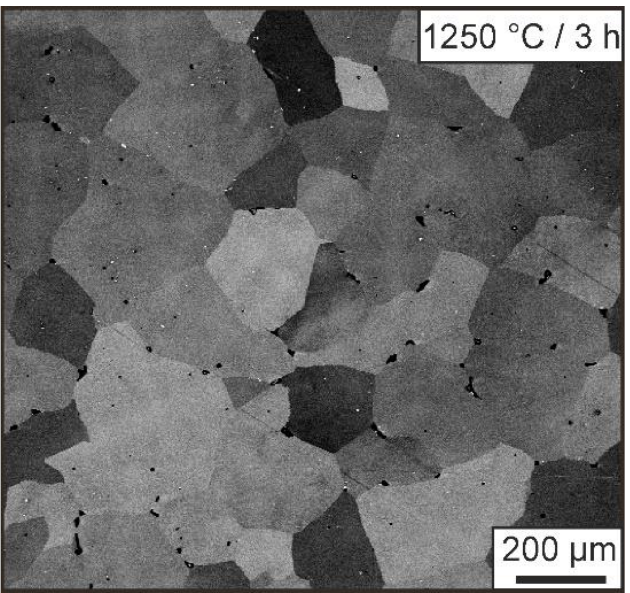
Figure 2. SEM image of the homogenized microstructure of CoWAlloy1 after a heat treatment at 1250 °C for 3 h.